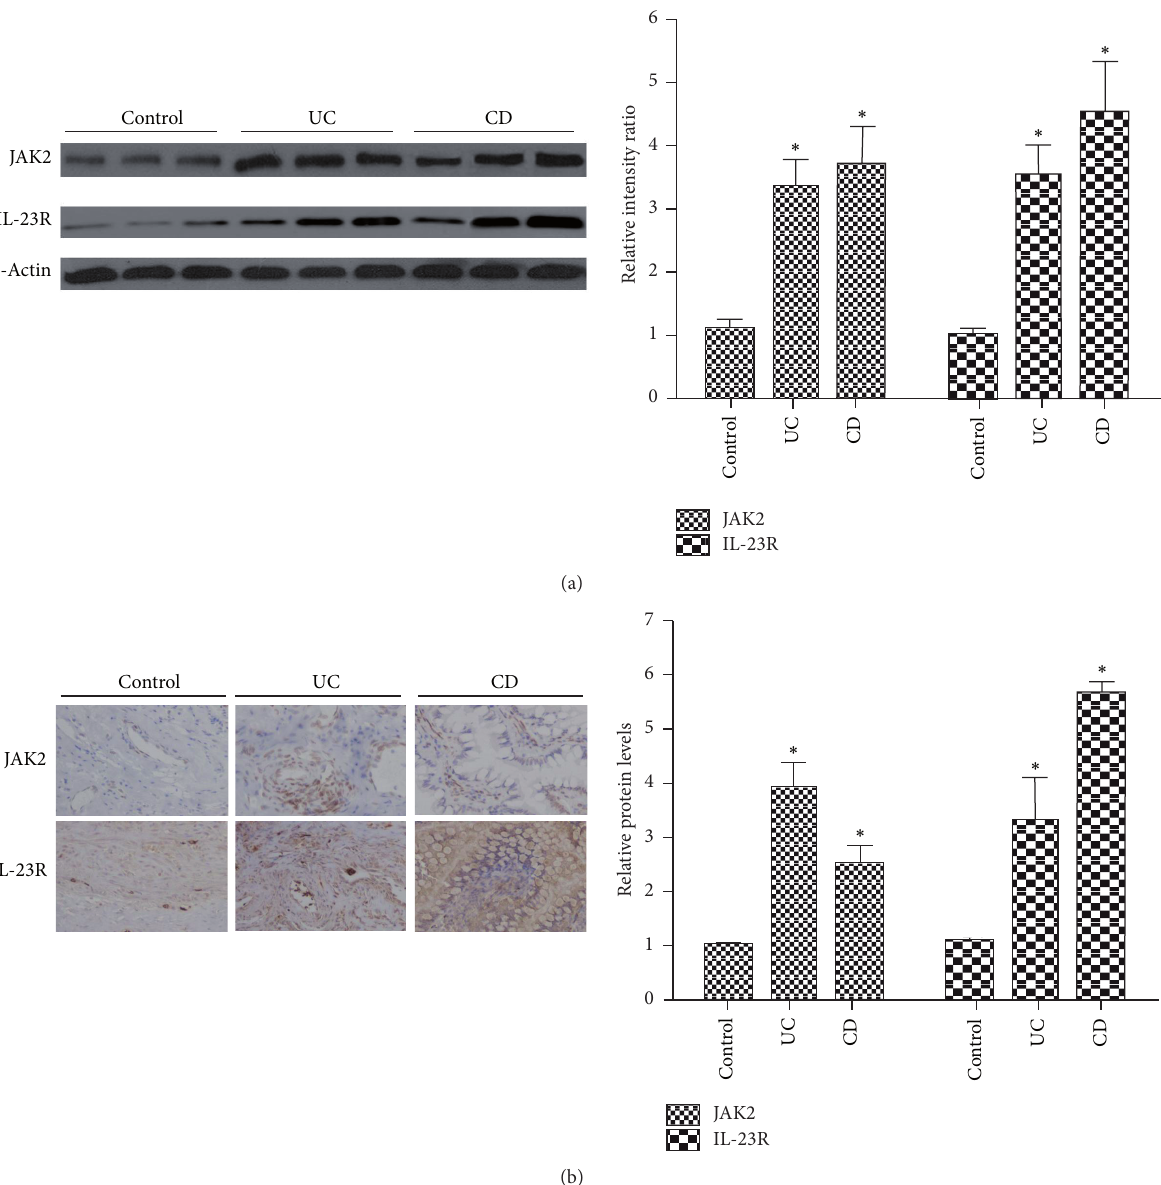
Figure 4: The expression levels of JAK2 and IL-23R protein in UC and CD patients. Compared with healthy controls, the local protein expression of JAK2 and IL-23R was enhanced in patients with UC and CD. (a) Quantitative analysis of the expressions of JAK2 and IL-23R relative to the intensity of 𝛽 -actin by western blot. Autoradiograms were quantified with scanning densitometry. (b) Immunohisto chemical analysis for JAK2 and IL-23R quantification. (magnification: × 100). “ ∗ ”indicated 𝑃 < 0.05 versus control